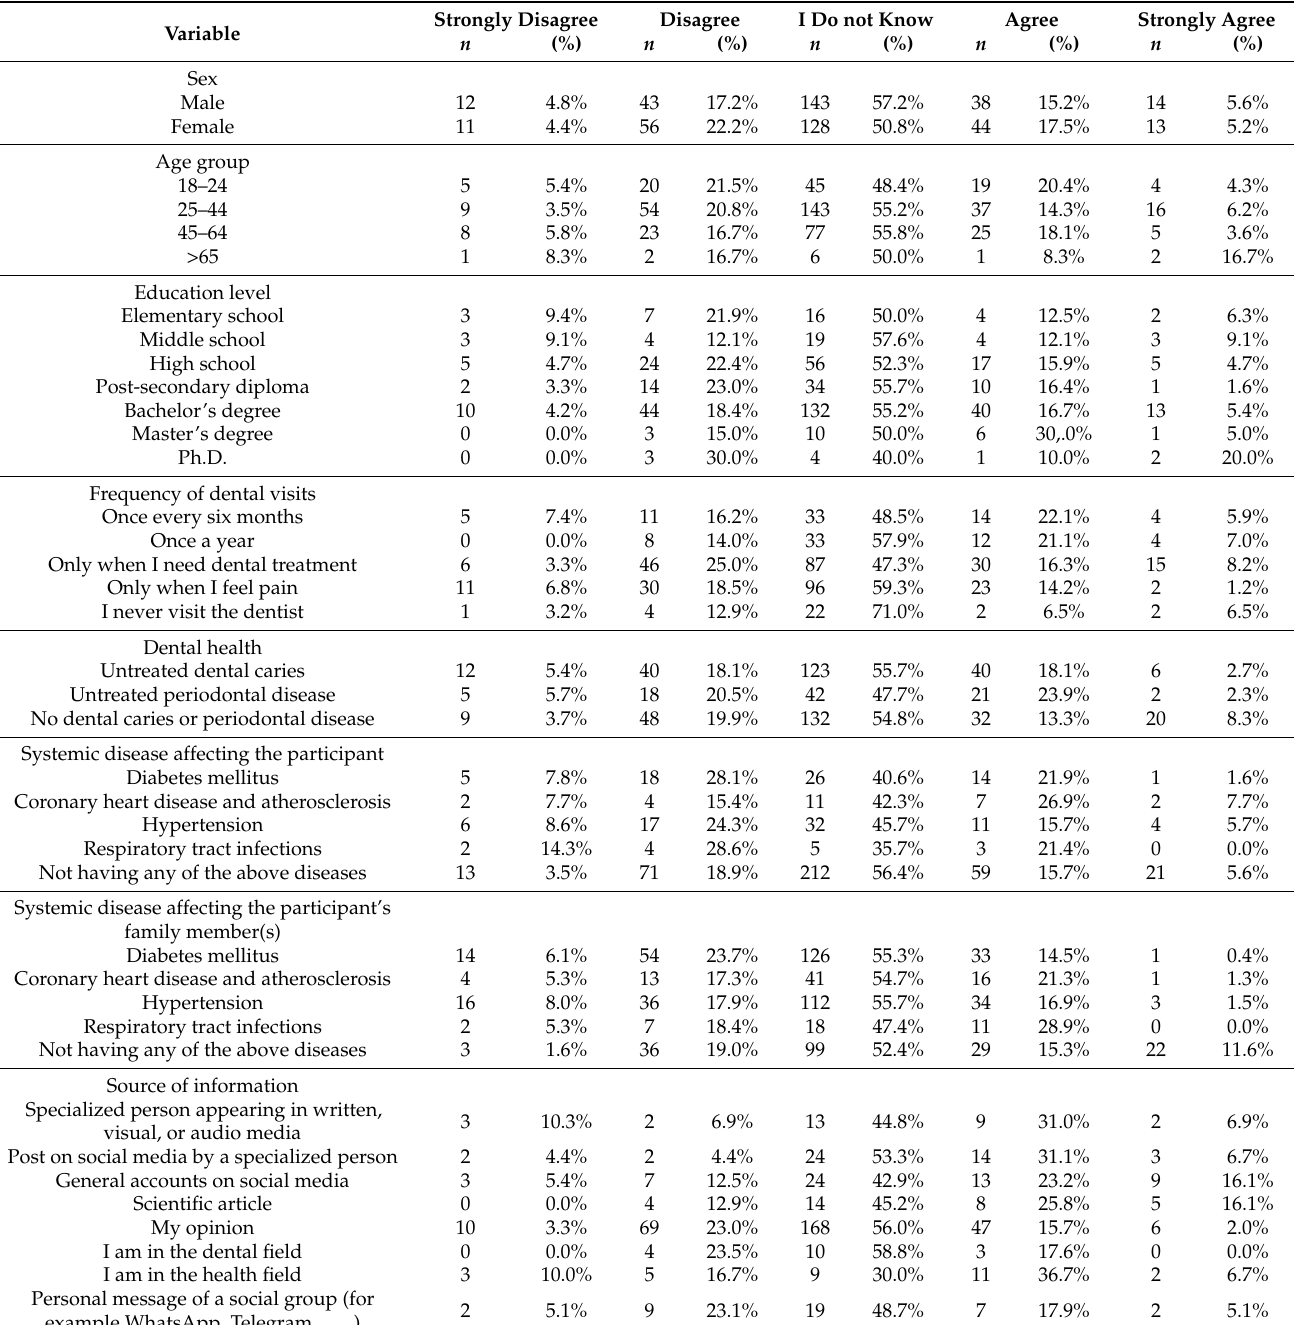
Table 14. Awareness about the association between periodontal disease and respiratory tract infec- tions distributed by various factors.